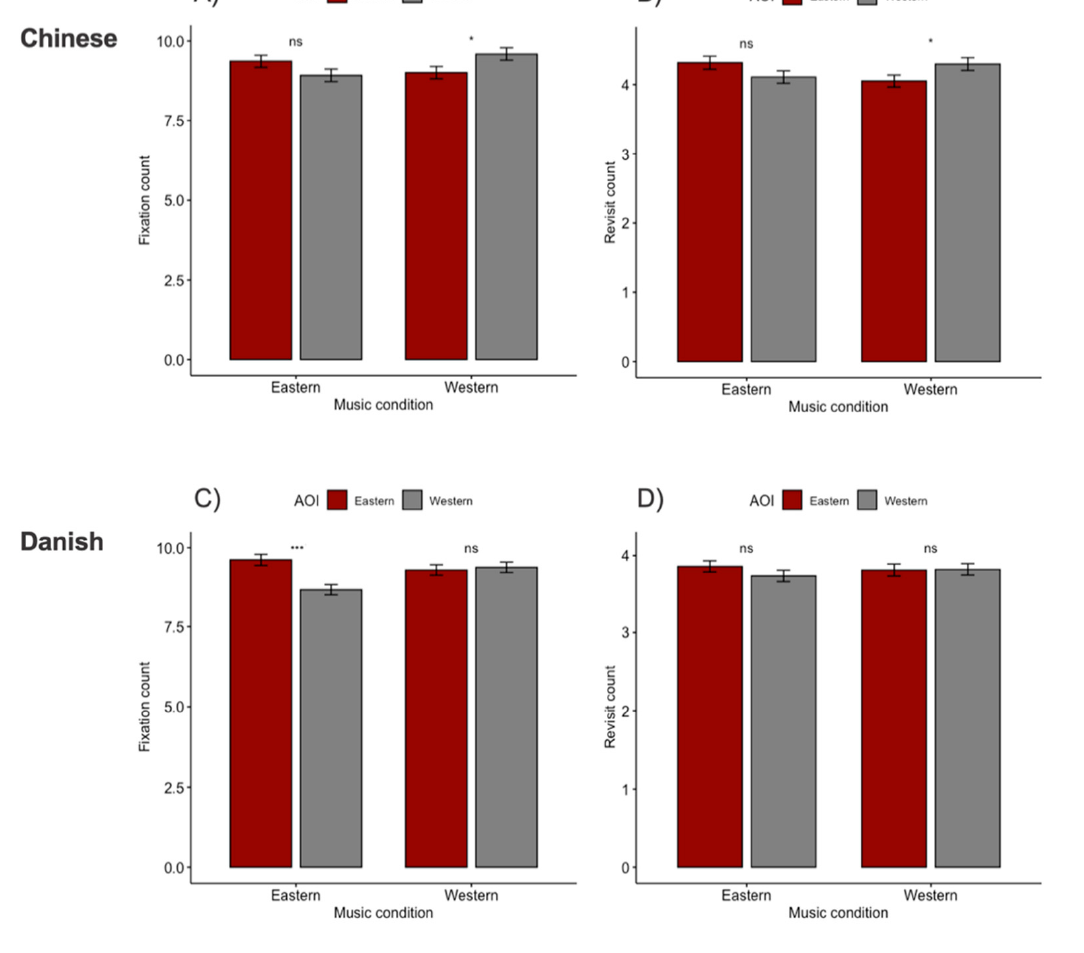
Figure 4. Barplots with standard error of post hoc analyses. Dark red denotes to Eastern food items / AOI and grey denotes Western food items / AOI for the two music conditions. Top two plots illustrate results of ( A ) fixation count and ( B ) revisit count for Chinese participants and bottom two plots show ( C ) fixation count and ( D ) revisit count for Danish participants. ns indicates no significance, * indicates p < 0.05, *** indicates p < 0.001.